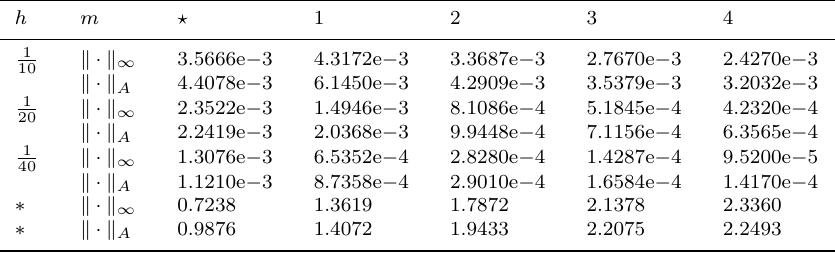
Table 1. Numerical results in the case a = 1 e − 1.